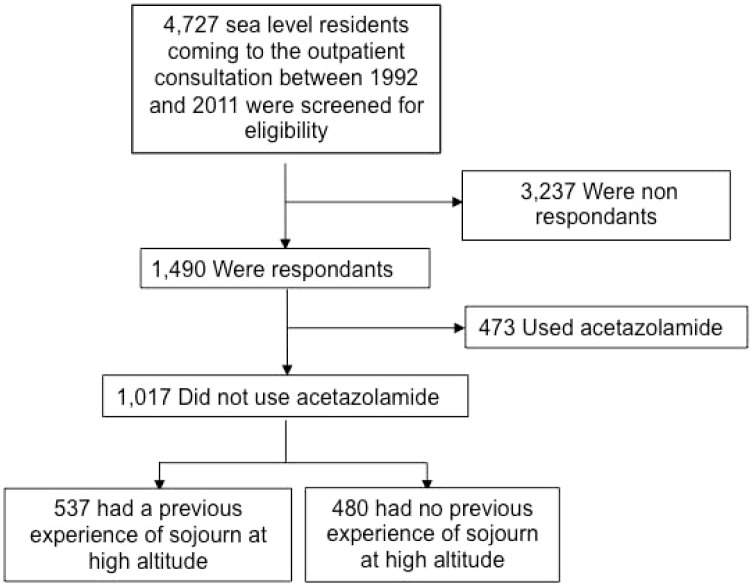
Flow chart of the study.